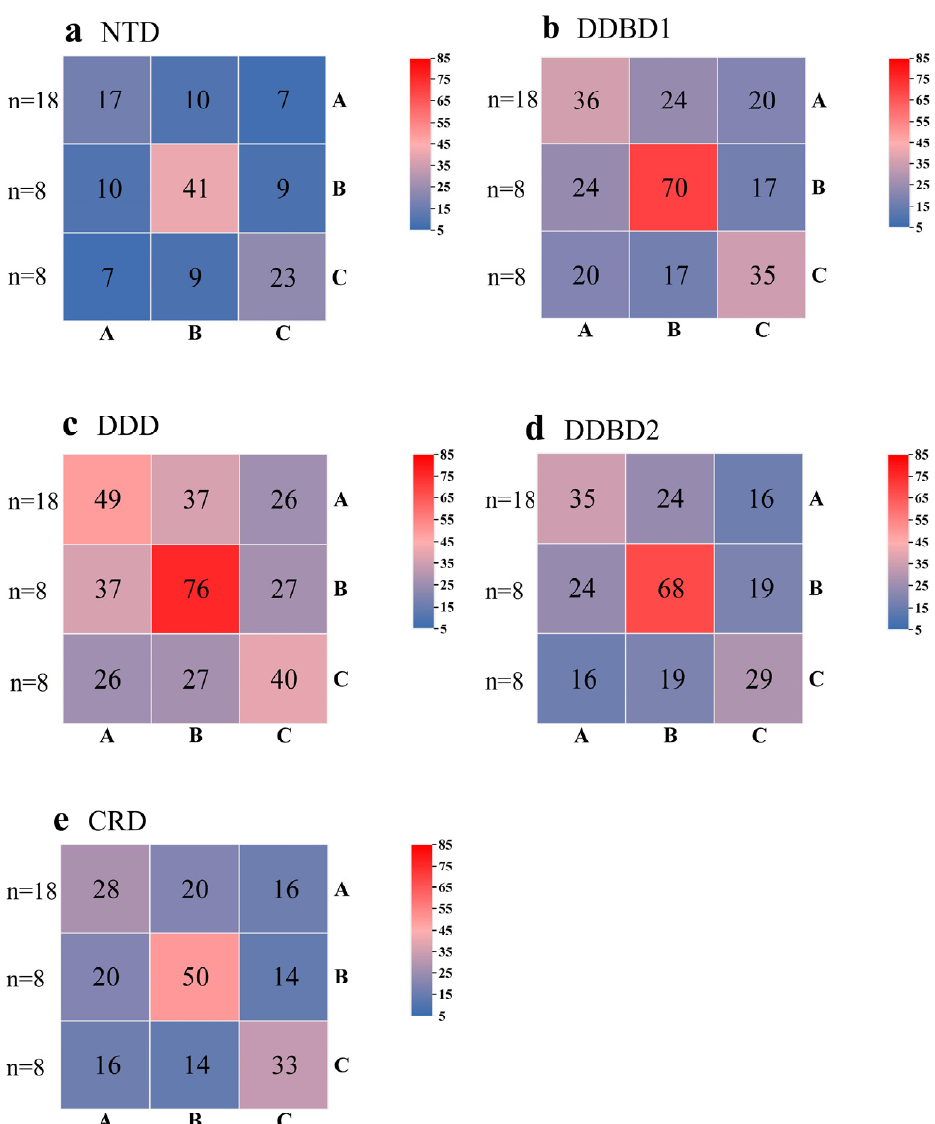
Figure 6. Sequence identities between A–C clades. The numbers in the heatmap are the percentage of the average values of the sequences’ identities of the two types of transposons in the corresponding row and column, and “ n ” represents the number of each type of transposon sequence ( a – e ). The average values of sequence identities were measured by pairwise comparison of sequences of NTD ( a ), DDBD1 ( b ), DDD ( c ), DDBD2 ( d ), and CRD ( e ) of complete PB transposases ( ≥ 500 aa).